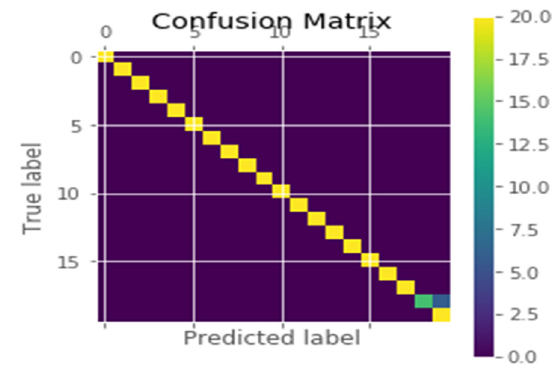
TABLE 2: EXPERIMENTAL RESULTS PRECISION, RECALL AND FI-SCORE FOR FINGERPRINT, SIGNATURE AND FUSION OF FINGERPRINT AND